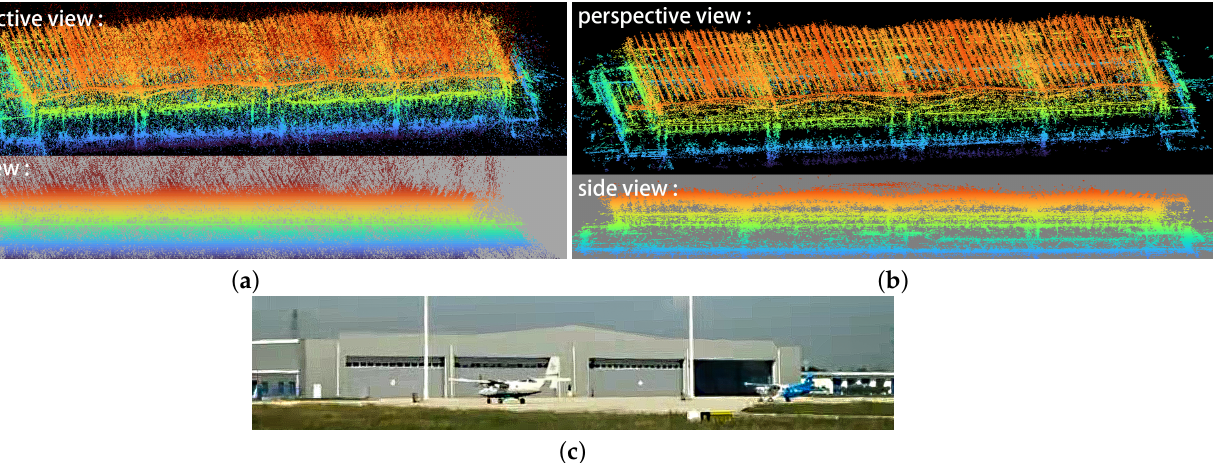
Figure 10. Comparison of 3D reconstruction from Palm’s method and our method; 3D point clouds are presented with a perspective view and a side view. By comparison, the roof structure is more